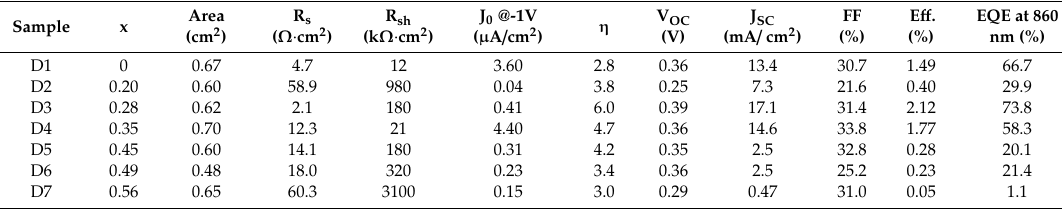
Table 2. Summary of the electrical performance of the Al x In 1 − x N on Si (100) devices. The area of the devices was estimated taking into account the area of the top n-contact of ~0.13 cm 2 .